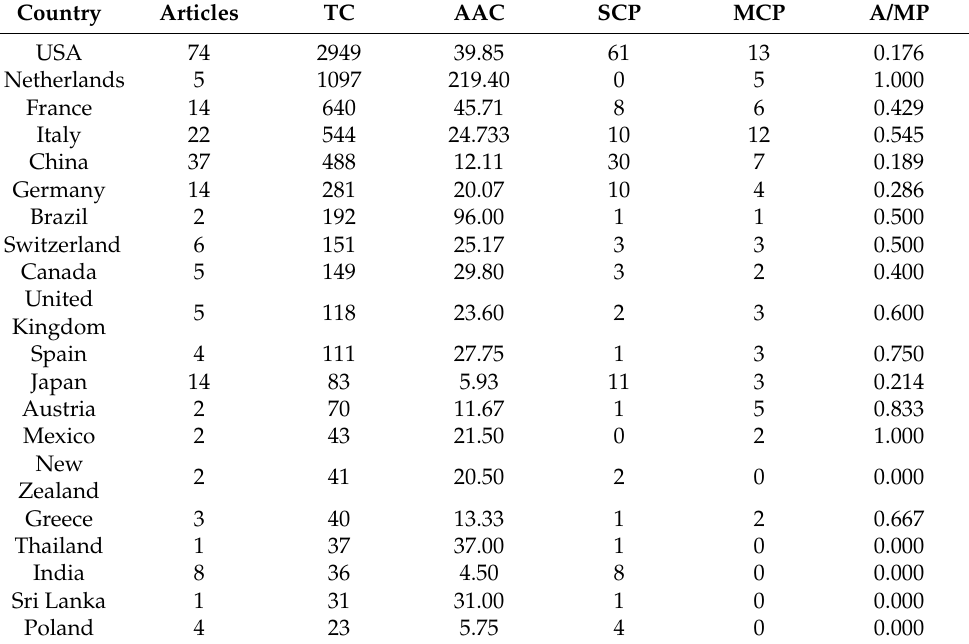
Table 2. Top 20 countries most cited per average article citation on EOS and PM from 1979–2019.